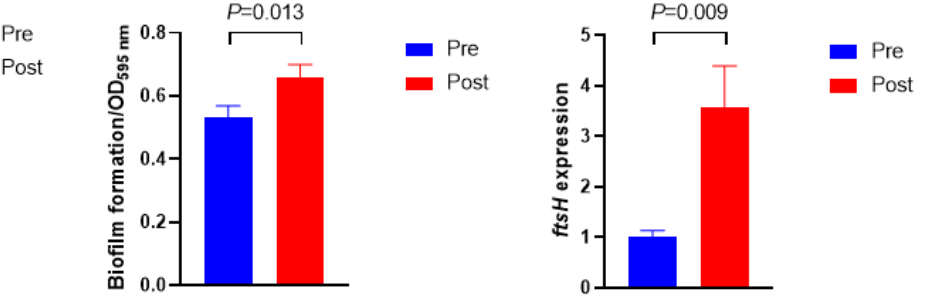
Figure 3. Microbial density, biofilm formation, and its related gene expression before (Pre) and after (Post) diet shift.